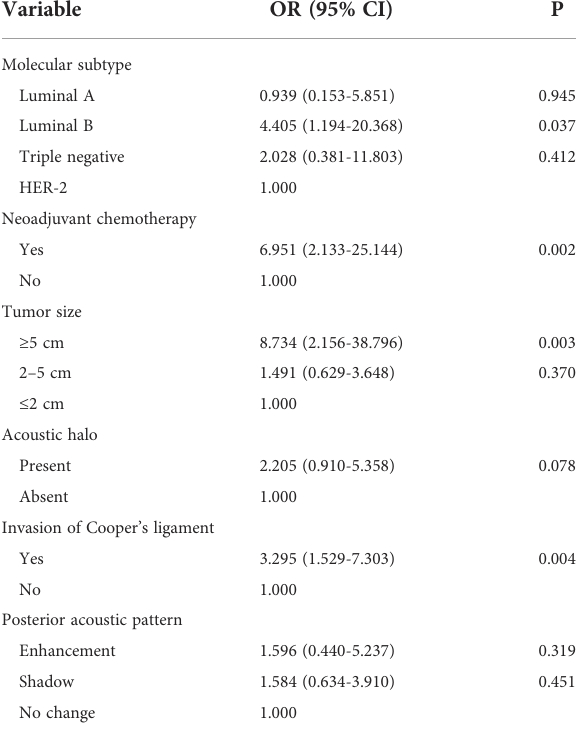
TABLE 7 Multivariate-logistic regression analysis of the ABVS features and axillary lymph node tumor burden. Variable OR (95% CI) Molecular